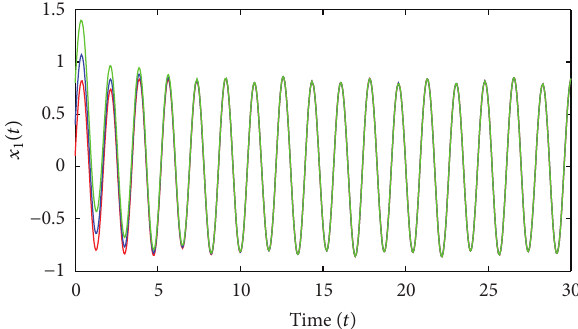
Figure 2: Global exponential stability of state variable 𝑥 1 (𝑡) .